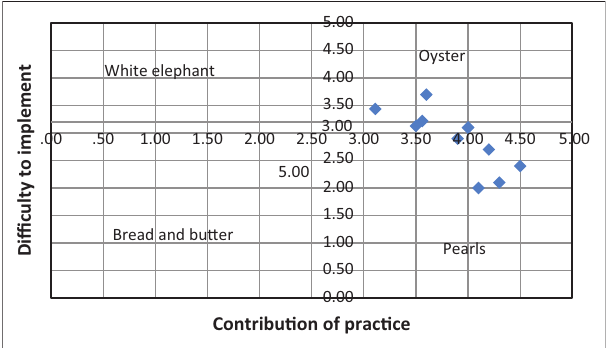
FIGURE 4: Contribution versus difficulty to implement practices to overcome operational barriers in reverse logistics.